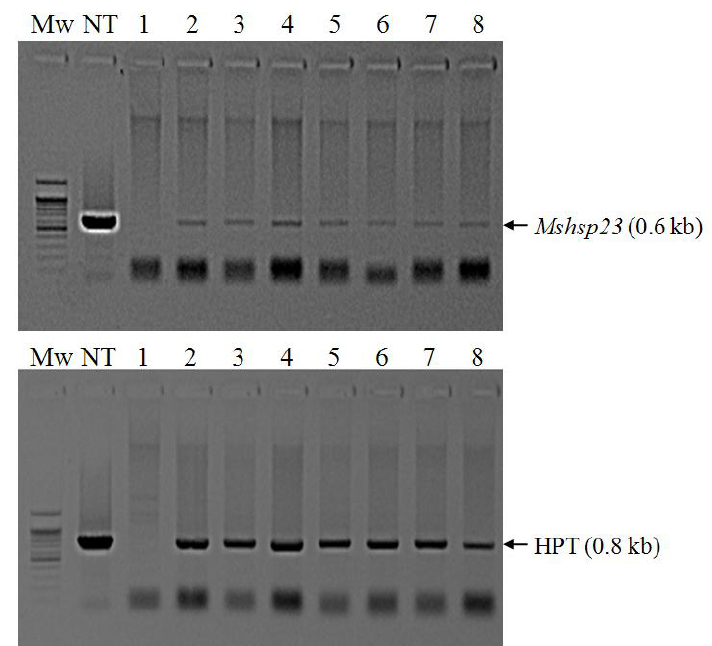
Figure 2. Integration of the transgene into tall fescue plants. PCR amplification of a 630-bp fragment of MsHsp23 (top panel) and an 804-kb fragment of hpt (bottom panel) is shown.